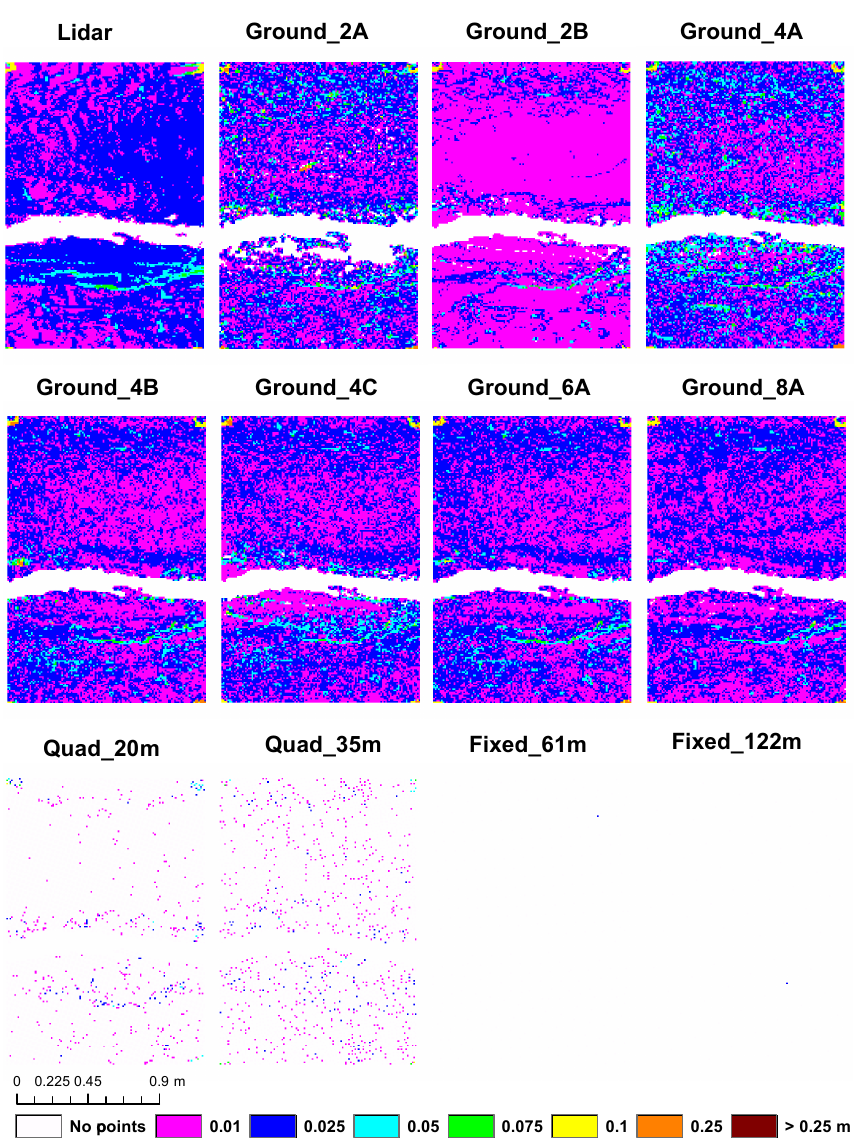
Figure 7. Elevation range (difference between the minimum and maximum elevation) represented as individual colors within a 1 × 1cm virtual grid. Points located in the channel were removed to match the area covered by the lidar dataset (herein considered as a